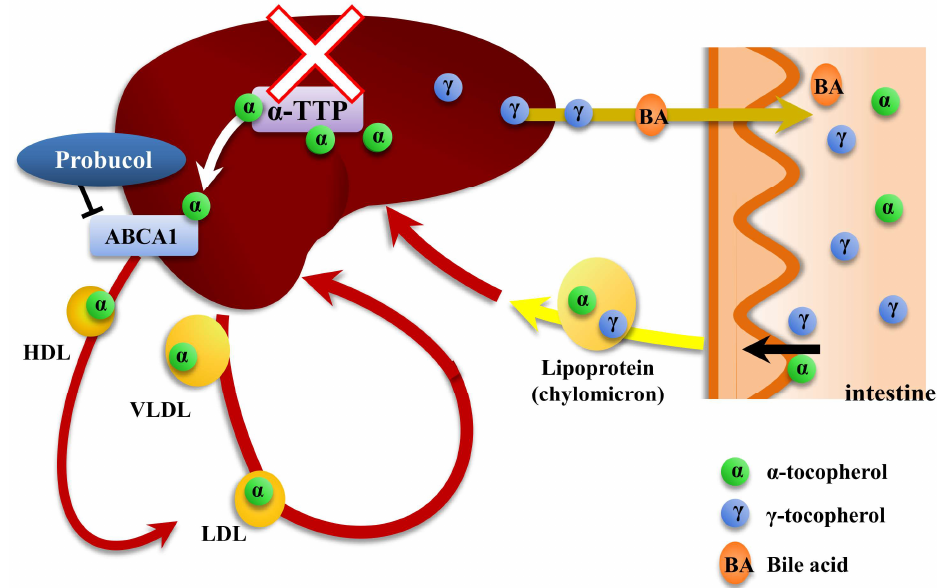
Figure 1. Possible induction of vitamin E deficiency by the inhibition of α -tocopherol efflux from liver cells. Both α - and γ -tocopherols are absorbed similarly from the intestine and transported by chylomicrons in plasma. Following the uptake of chylomicrons by the liver, only α -tocopherol is preferentially transported and localized to plasma membrane of liver cells by α -tocopherol transfer protein ( α -TTP). It is subsequently incorporated into lipoproteins, resulting in recirculation of this tocopherol in the body. On the other hand, γ -tocopherol is taken up by the liver and eventually secreted into bile. ATP-binding cassette transporter A1 (ABCA1) participates directly in the transport of α -tocopherol from liver cells to Apo A-I, which is the major protein component of HDL. Thus, α -TTP or ABCA1 might be suitable targets to induce vitamin E deficiency in circulation.